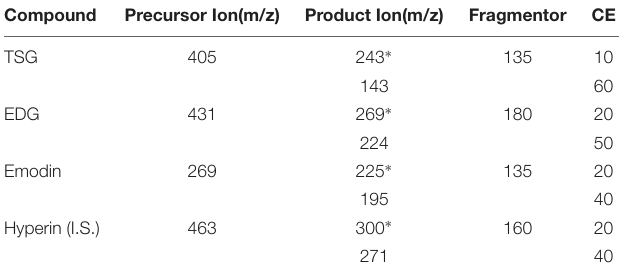
TABLE 1 | Optimized multiple reaction monitoring parameters for the detection of analytes and internal standards ( ∗ quantitative